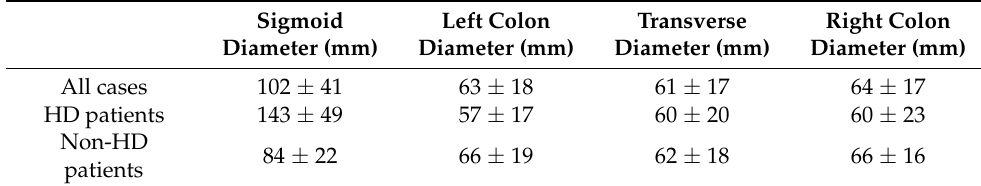
Figure 2. Sigmoid colon volvulus in a 14-year-old girl. Coronal T2 weighted MRI images demonstrate closed-loop obstruction of the sigmoid colon with severe visceral dilatation ( A ) and whirlpool sign ( B ); abdominal free fluid is also depicted. Table 2. Mean colon diameter based on bowel enema evaluation; HD = Hirschsprung’s